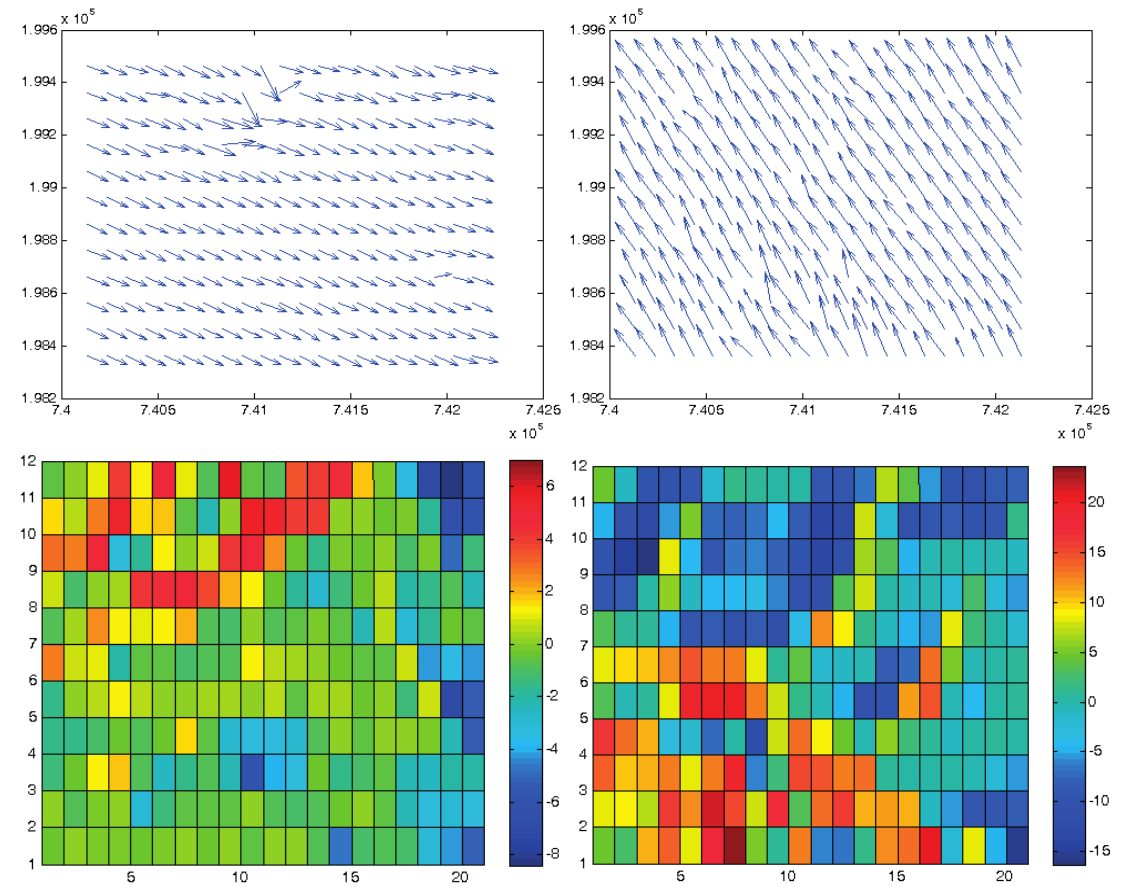
Figure 17. Change detection analysis: results received by using the proposed mechanism of hierarchical registration and matching ( left ), and results received via the straightforward coordinate-based comparison ( right ). Values are in